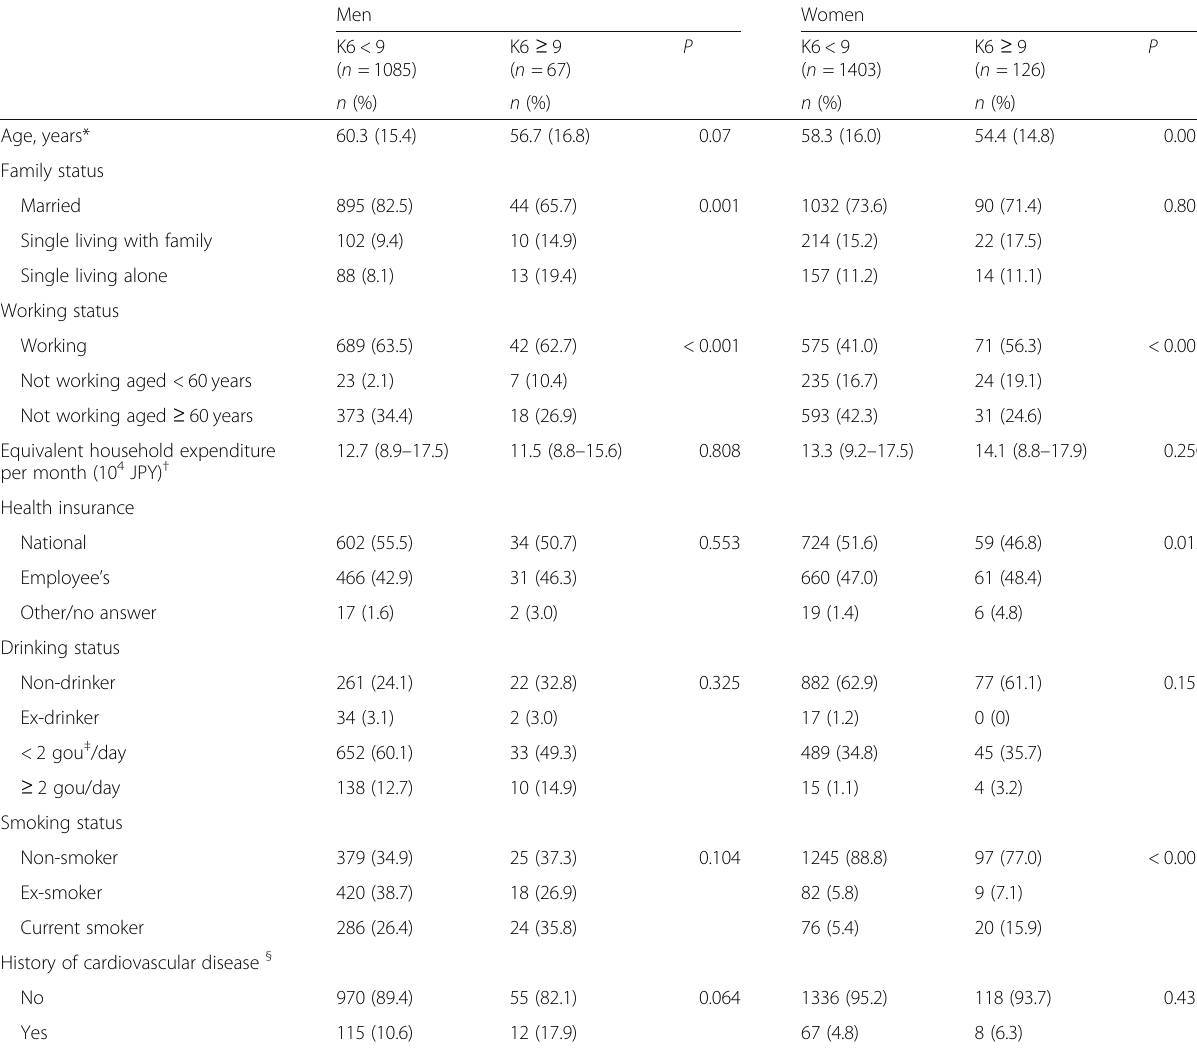
Table 1 Characteristics of study participants stratified by the depressive status with the Kessler 6 scale. Japanese men and women aged 20 years and older. NIPPON DATA2010 baseline survey ( n =